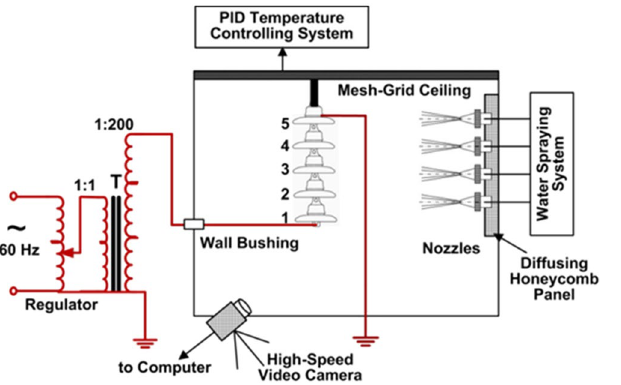
Figure 1. Schematic diagram of test setup at